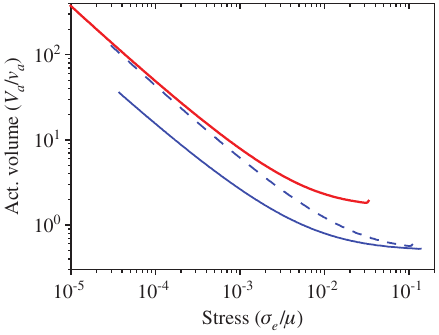
Figure 8 Dependence of activation volume on the external stress. Solid and dashed lines correspond to two- and one-peak distribu- tions g ( σ ), respectively. Short dashed line corresponds to more narrow one-peak